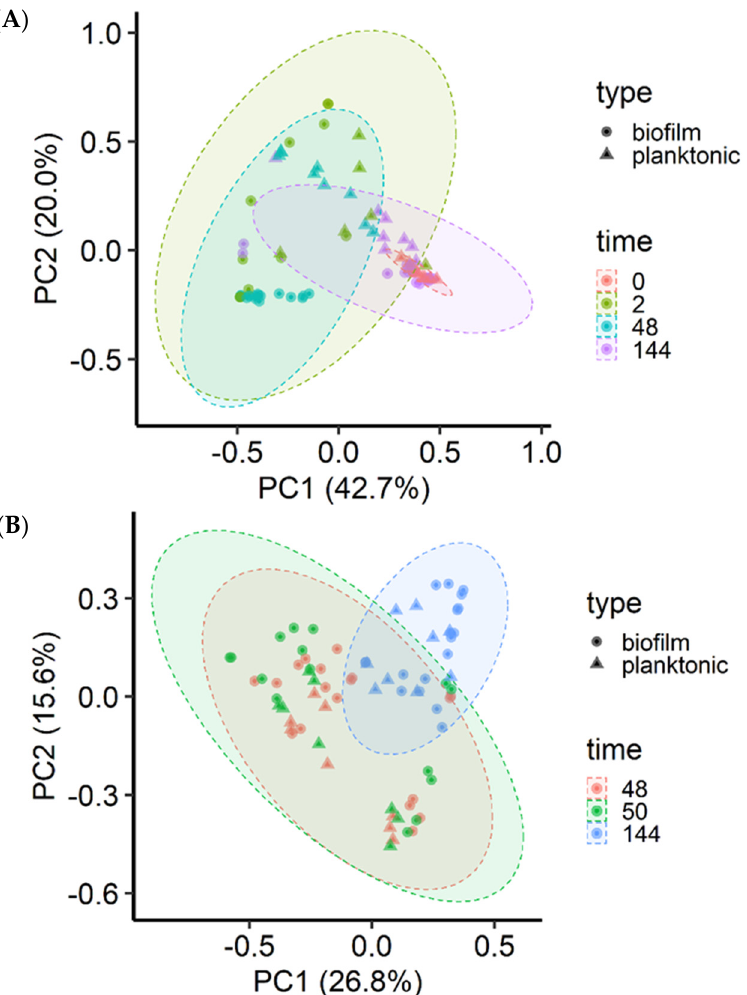
Figure 5. Principal coordinate analysis of the Bray-Curtis dissimilarities of the biofilm and planktonic microbiota. Meat processing surface bacteria (MPB), Salmonella Typhimurium, and Escherichia coli O157:H7 in Lennox broth without salt were incubated in biofilm reactors at 15 °C for six days and sampled at various time points (h). S . Typhimurium and E . coli O157:H7 were introduced simultaneously with MPB ( A ) or delayed by 48 h ( B ).